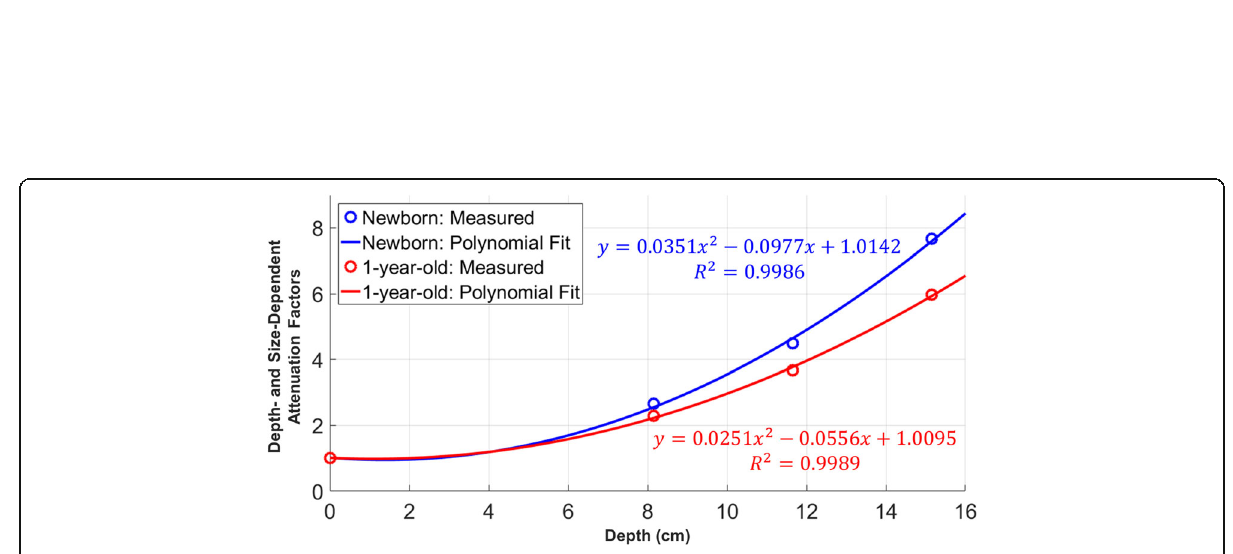
Fig. 4 Depth-dependent attenuation correction factors obtained in the phantom experiment. Blue : newborns. Red